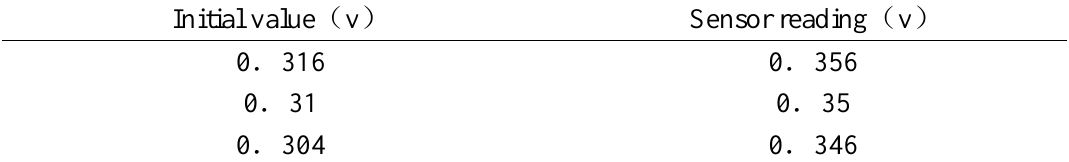
Table 1. Measured values at the different initial